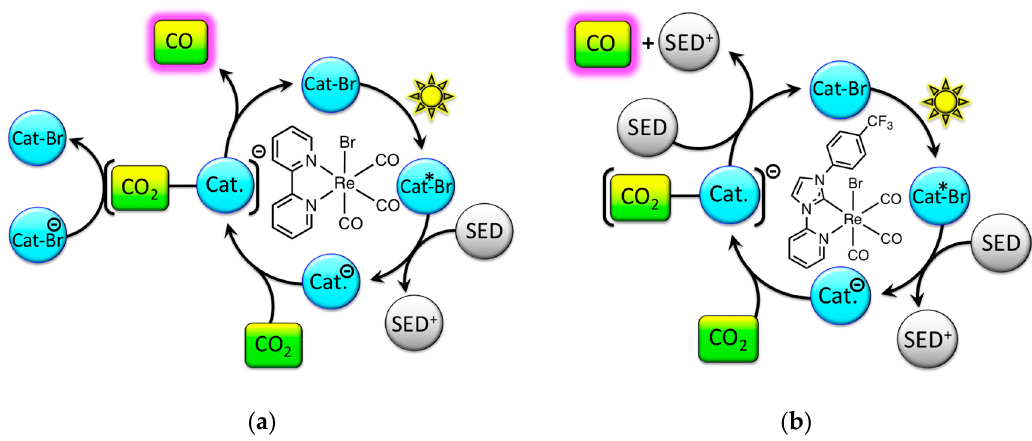
Figure 2. Generic catalytic cycles for catalysts that reduce CO 2 after ( a ) the second catalyst reduction event, such as benchmark bpy-based Re(bpy)(CO) 3 Br, or ( b ) the first catalyst reduction event, such as NHC-based Re(pyNHC-PhCF 3 )(CO) 3 Br. The second SED electron transfer likely occurs after CO